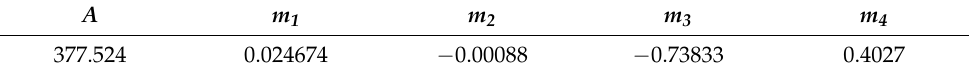
Table 4. Parameters of the (Equation (2)) model for the first iteration of the fitting algorithm.